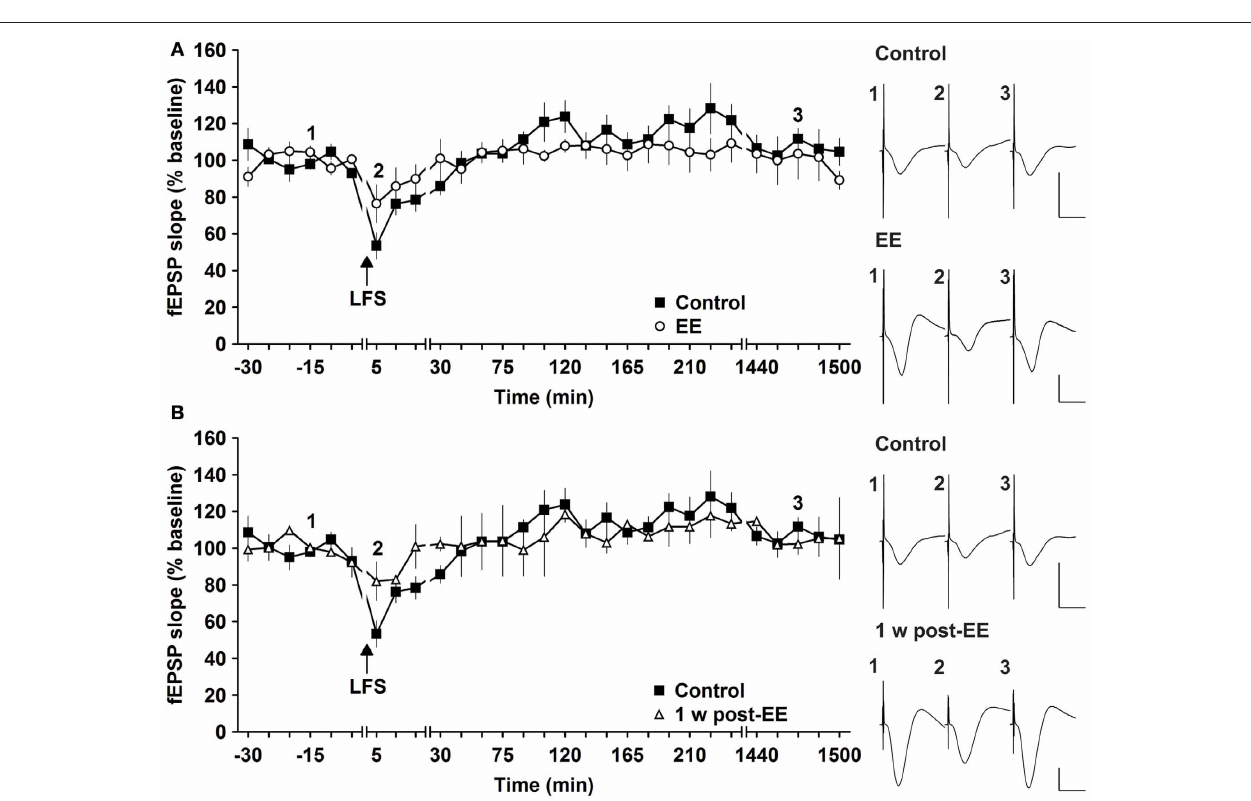
FIGURE 3 | Mean fEPSP values of initial 30min and last 30min of recordings of potentiation after EE. Bar charts show the mean fEPSP values recorded either in the first 30min immediately after application of HFS, or the last 30min (ca. 24h after HFS) in mice stimulated with either one application of 50 pulses at 100Hz, or two applications of 50 pulses at 100Hz. LTP elicited with the stronger protocol (2 × 50 pulses) lasts for over 24h but does not respond to EE (compared to non-enriched controls). LTP elicited